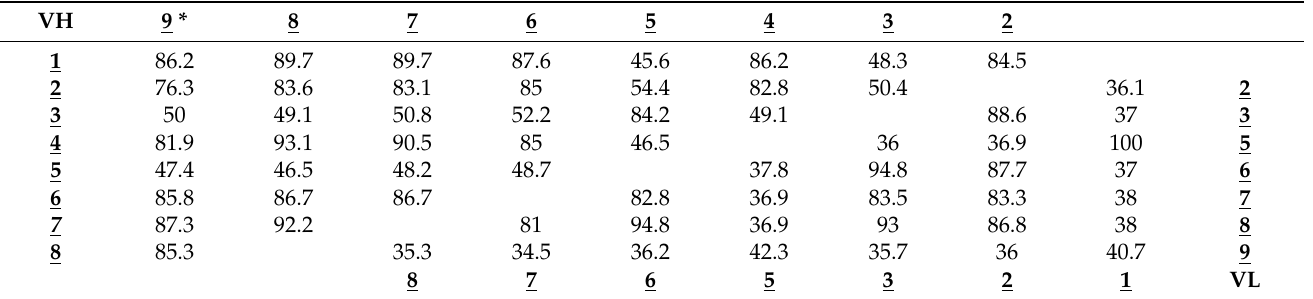
Table 1. Similarity (% identity) of the a/a sequences of the VH and VL fragments of the selected recombinant Abs.